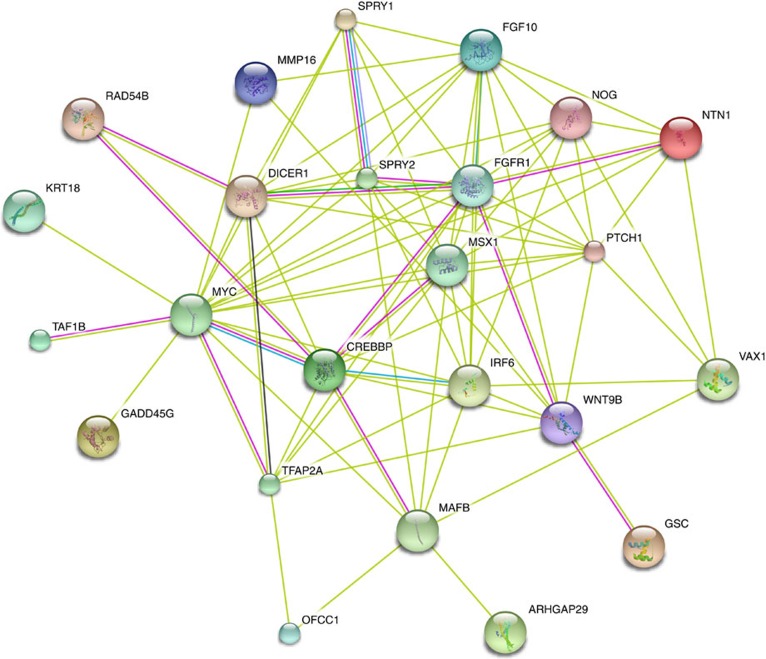
Functional similarity network of genes in the 26 NSCLP associated loci.The network in this figure is constructed for the 28 notable genes from the present study. Genes and their nodes that are not connected to any other node in the network are omitted. Thus, 24 out of the 28 genes are left and highly involved in the pathway network. The network nodes are proteins. The edges represent the predicted functional associations. An edge may be drawn with up to seven differently coloured lines—these lines represent the existence of the seven types of evidence used in predicting the associations. A red line indicates the presence of fusion evidence; a green line—neighbourhood evidence; a blue line—coocurrence evidence; a purple line—experimental evidence; a yellow line—textmining evidence; a light blue line—database evidence; a black line—coexpression evidence.